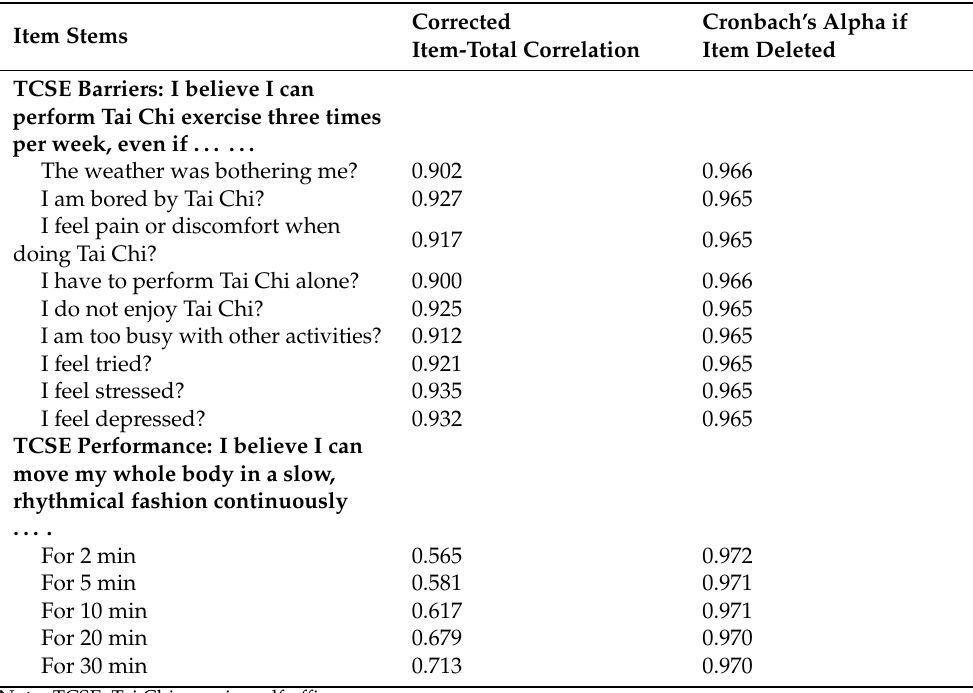
Table 3. Item analysis for the TCSE scale (Mandarin Chinese version).